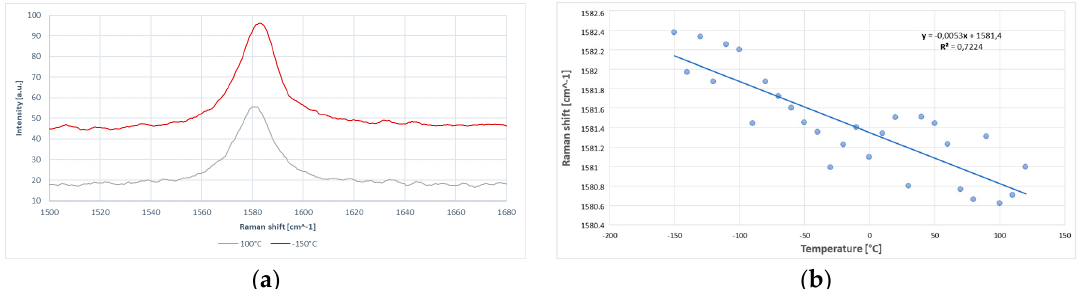
Figure 5. Temperature dependence of the G-peak frequency for GnPs. ( a ) The insets show the redshift of the G-peak region of the Raman spectrum from a single GnP recorded at two different temperatures; and ( b ) the measured data were used to extract the temperature coefficient for G-peak.